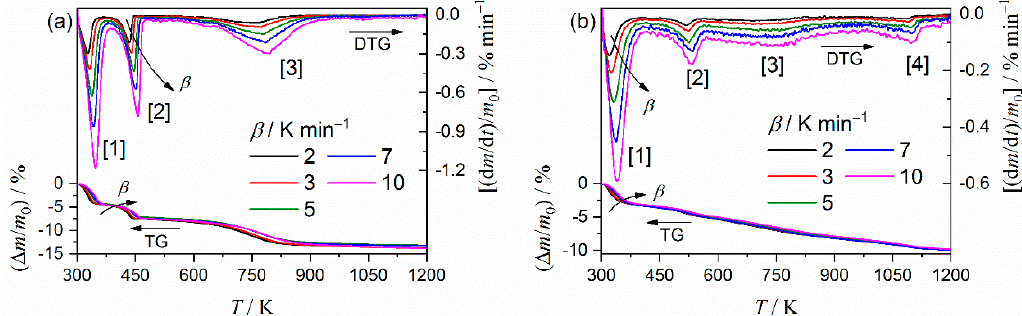
Figure 4. TG–DTG curves for the thermal decomposition of the purified clay minerals recorded at different β in a flow of N 2 gas: ( a ) Palygorskite and ( b ) sepiolite.